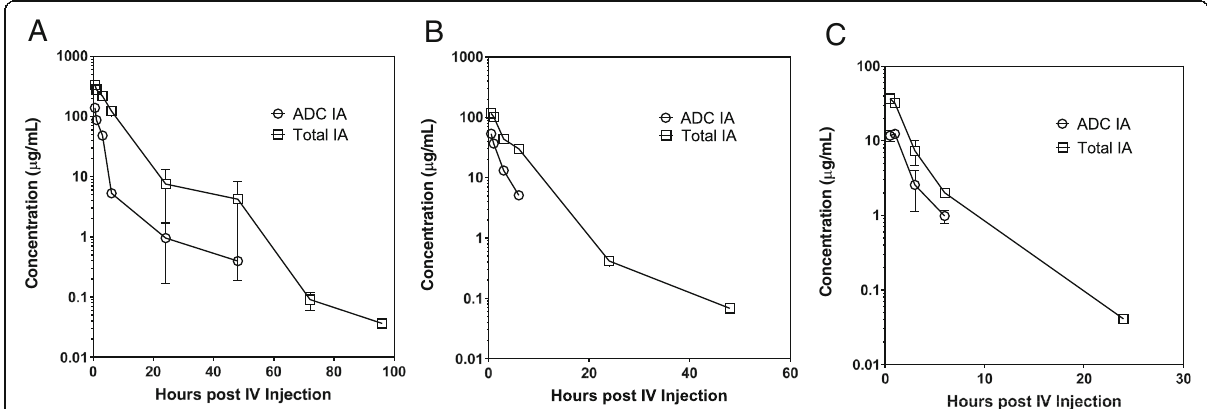
Fig. 3 In vivo stability of anti-CD74-Phos-Bud. To assess the stability of anti-CD74-Phos Bud in mice, the levels of antibody was determined by total antibody immunoassay (Total IA) and levels of intact ADC was determined by ADC specific immunoassay (ADC IA) on plasma samples from human CD74+ transgenic (Tg) mice IV dosed with 30 mg/kg ( a ), 10 mg/kg ( b ) and 3 mg/kg ( c ). Data plotted are mean from two mice per time point. Error bars correspond to the range. Error bars smaller than the symbol are not visible